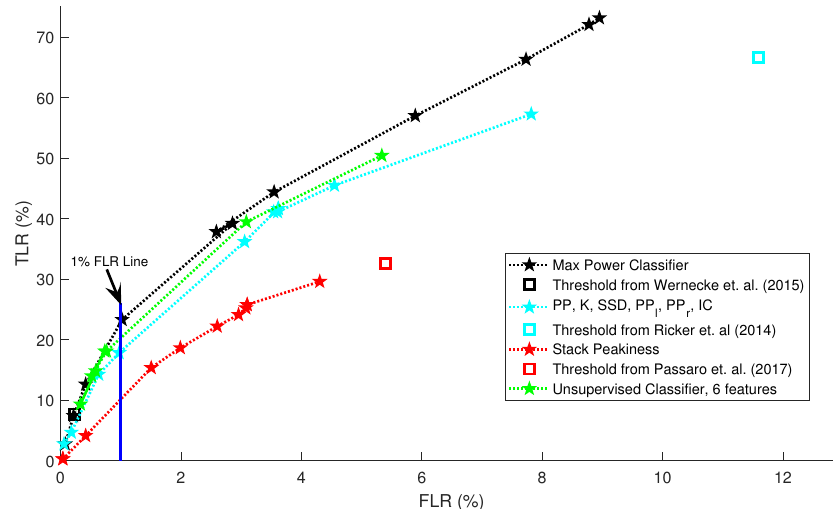
Figure 3. ROC graph depicting the change in performance for different thresholds and different cluster numbers. Each line and marker represents a different altimeter classification method and the different weight for optimized threshold respectively. The square markers represent thresholds that were determined in previous studies. The 1% False Lead Rate (FLR) line is also